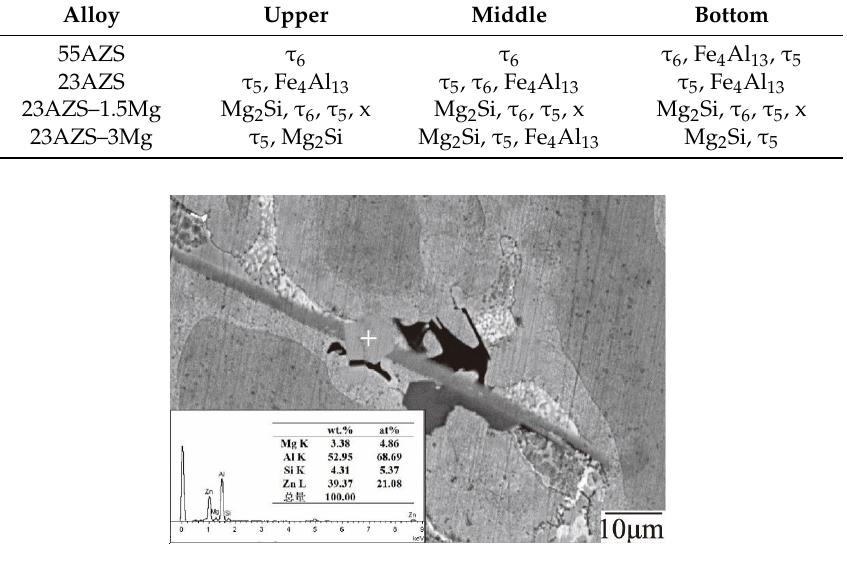
Figure 17. EDS result of the ‘X’ phase.